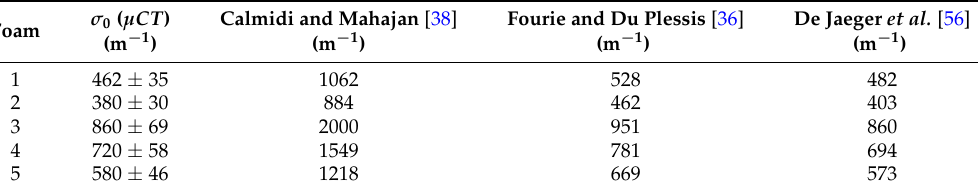
Table 2. Surface-to-volume ratio σ 0 results for correlations and model in the open literature for the foam samples shown in Table